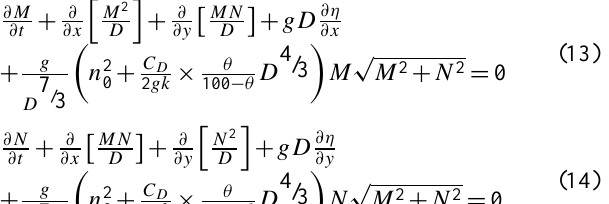
Fig. 6. Descriptive explanation of the force exerted by the tsunami